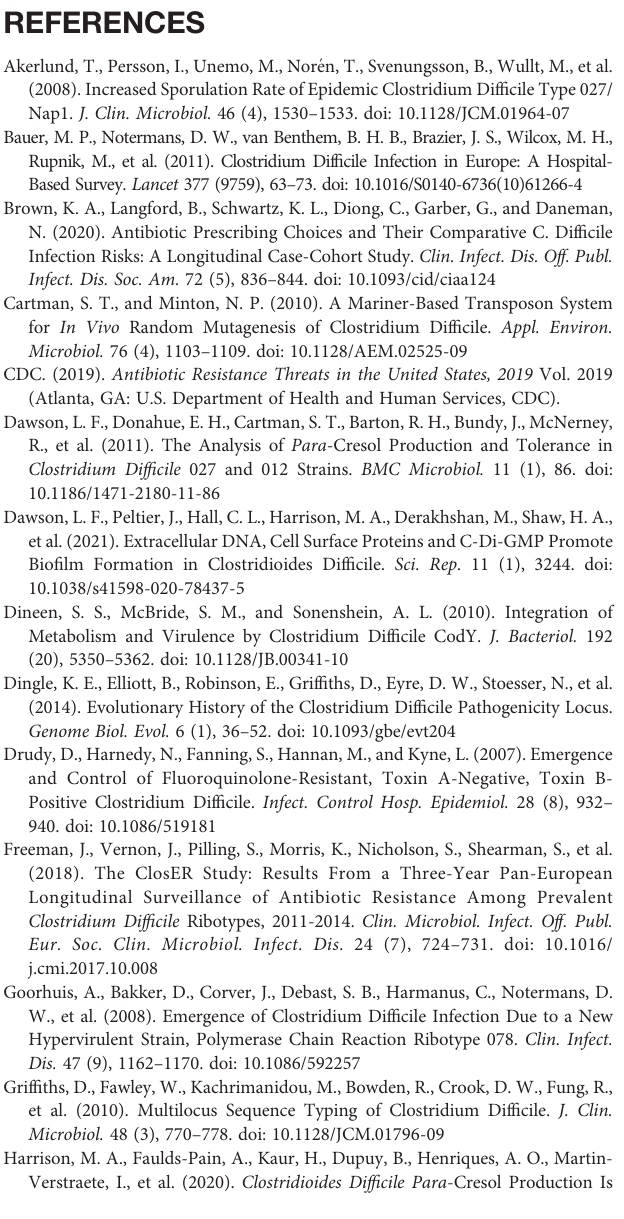
Supplementary Figure S6 | Alignment of hpdBCA -like operons carried by cryptic clades C-I, C-II, and C-III to hpdBCA operon from 630. Alignments were carried out using the Emboss Needle software from EMBL-EBI. Supplementary Table S1 | Peptides identi fi ed by mass spectrometry of HpdB – SNAP-tag. An anti-SNAP-tag western blot was run to probe the presence of